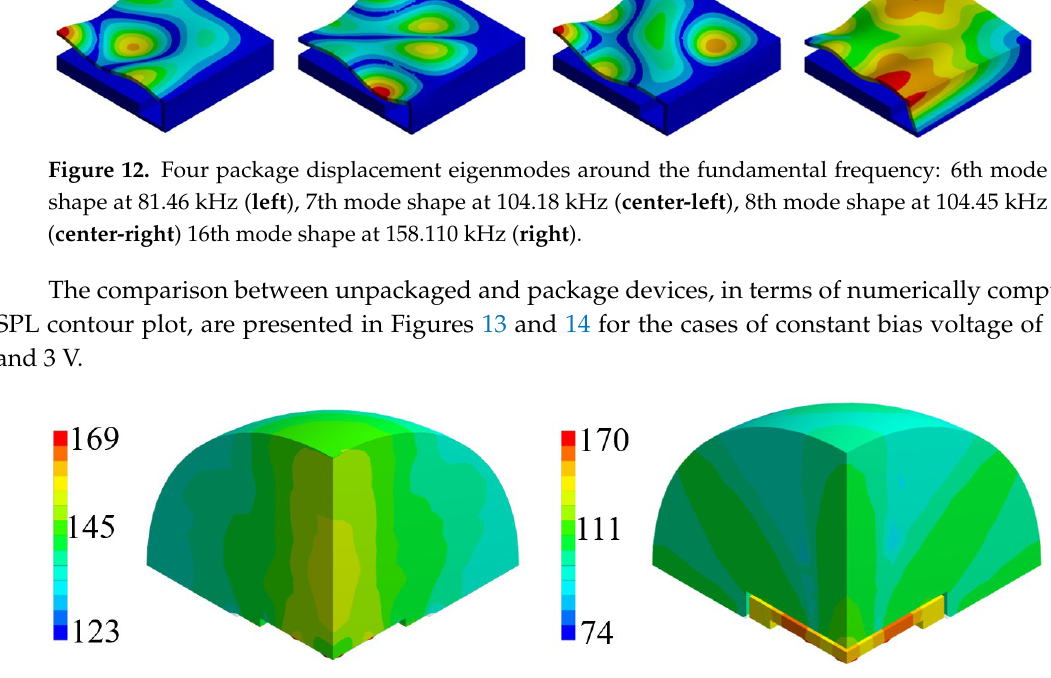
Figure 13. SPL contour plot (dB) at the performing fundamental frequency of 85.5 kHz (10 V bias): unpackaged device ( left ), packaged device ( right ).